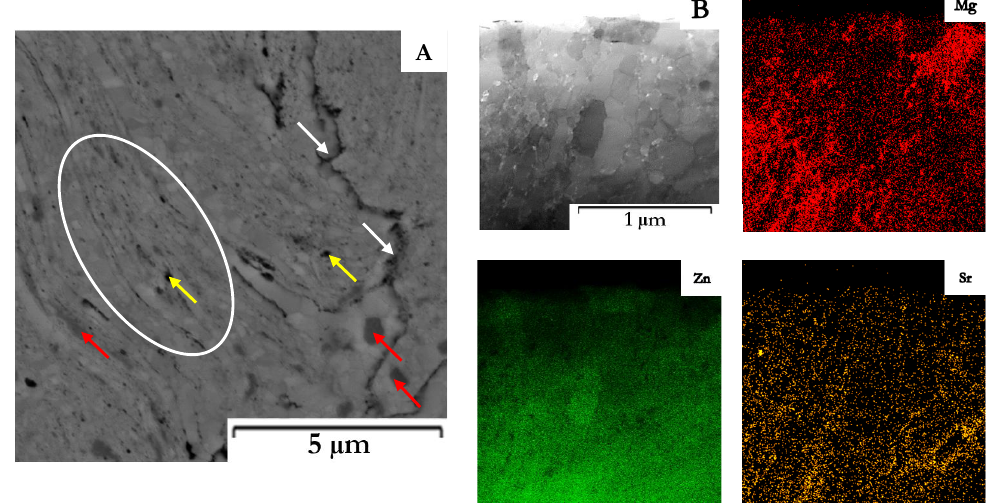
Figure 4. Microstructure of Zn–1Mg–0.5Sr alloy: ( A ) SEM, ( B ) Transmission electron microscope–Energy dispersive X-ray spectroscopy (TEM–EDS) map. Red arrows indicate Mg 2 Zn 11 and yellow the residues of SrZn 13 phases.